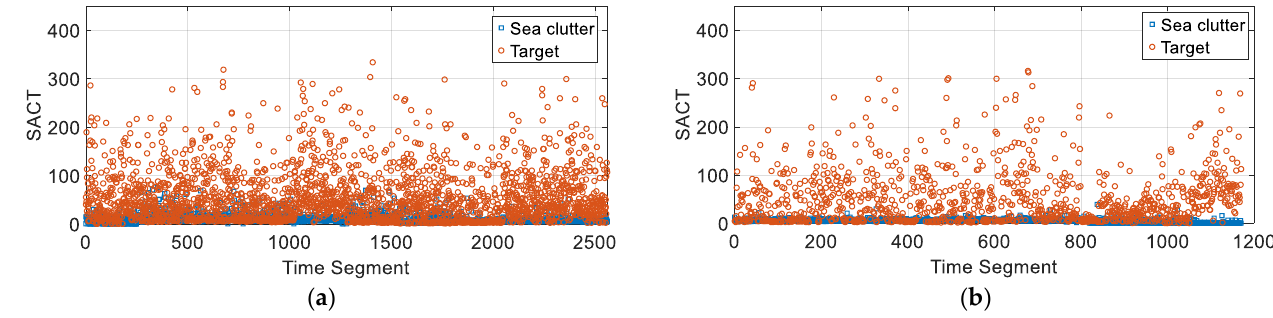
Figure 5. Statistical results of the SACT. ( a ) SACT of IPIX-1993. ( b ) SACT of IPIX-1998.